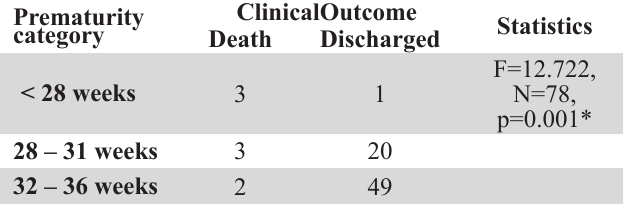
Table 5. Association Between Category of Prematurity and Clinical Outcome (n=78)